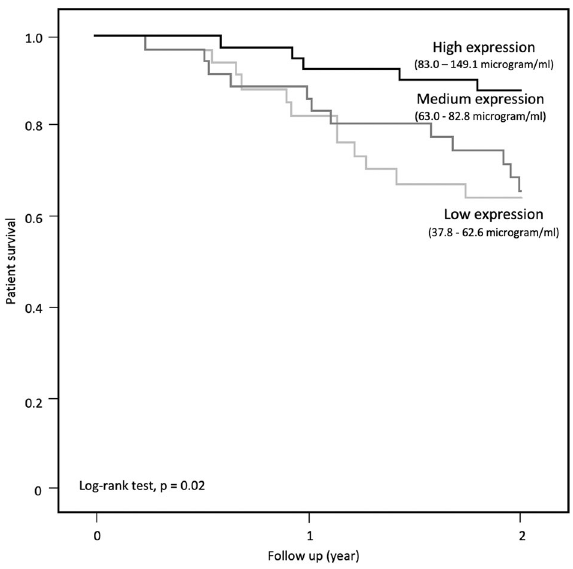
Figure 4. Kaplan Meier curve of survival.